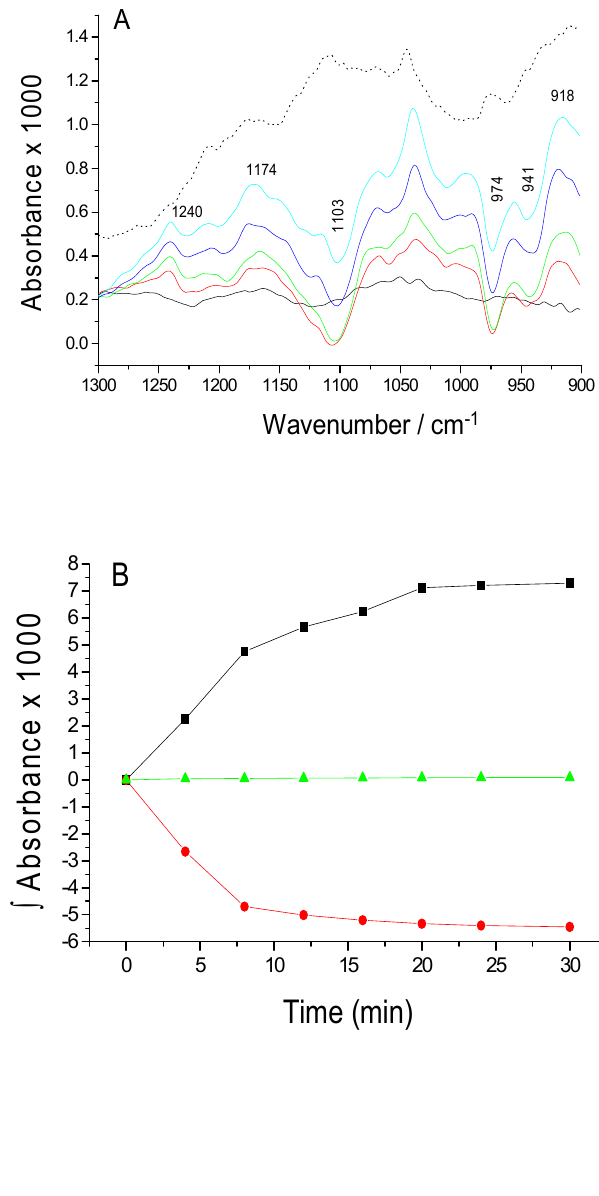
Figure 1. Enzymatic reaction of PK. (A) Series of overlaid spectra (solid lines) of infrared absorbance changes upon PEP and ADP addition to PK, observed for 30 min. The solid line spectra were recorded at 12 s (black), 4 min (red), 8 min (green), 16 min (blue) and 30 min (cyan). The dotted line is the last spectrum (30 min) of the control experiments (shifted up). (B) Kinetics of the enzymatic reaction of PK, monitored by integrated band intensities at 1240 cm -1 (black) and 941 cm -1 (red) and the control experiment (941 cm -1 , green). Time zero is the time when recording of the first spectrum after the background spectrum